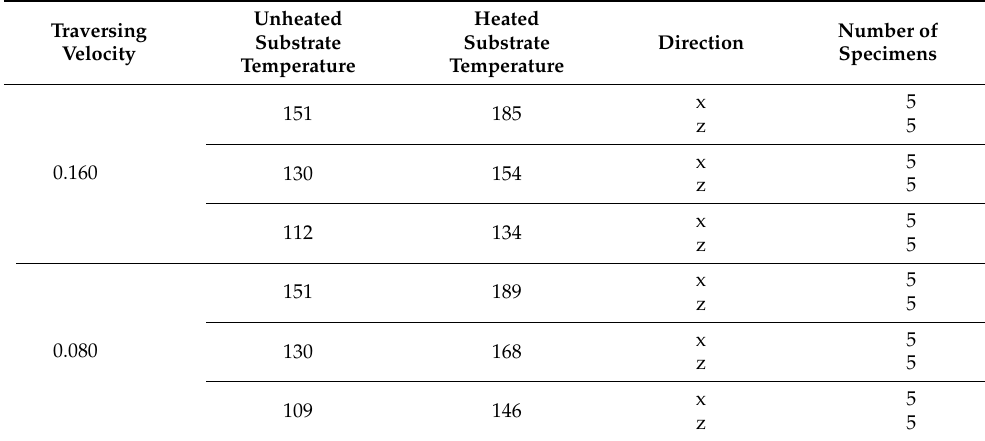
Table A1. Manufactured and tested heating setups for an emitter power of 100% and a heating distance of 100 mm.